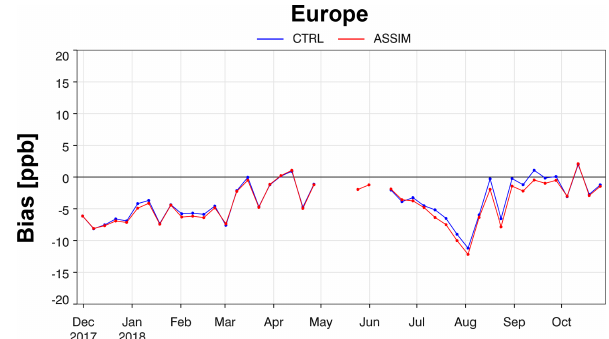
Figure 15. Time series of weekly averaged O 3 bias in ppb from ASSIM (red) and CTRL (blue) compared to GAW surface data av- eraged over Europe (between three and five sites).